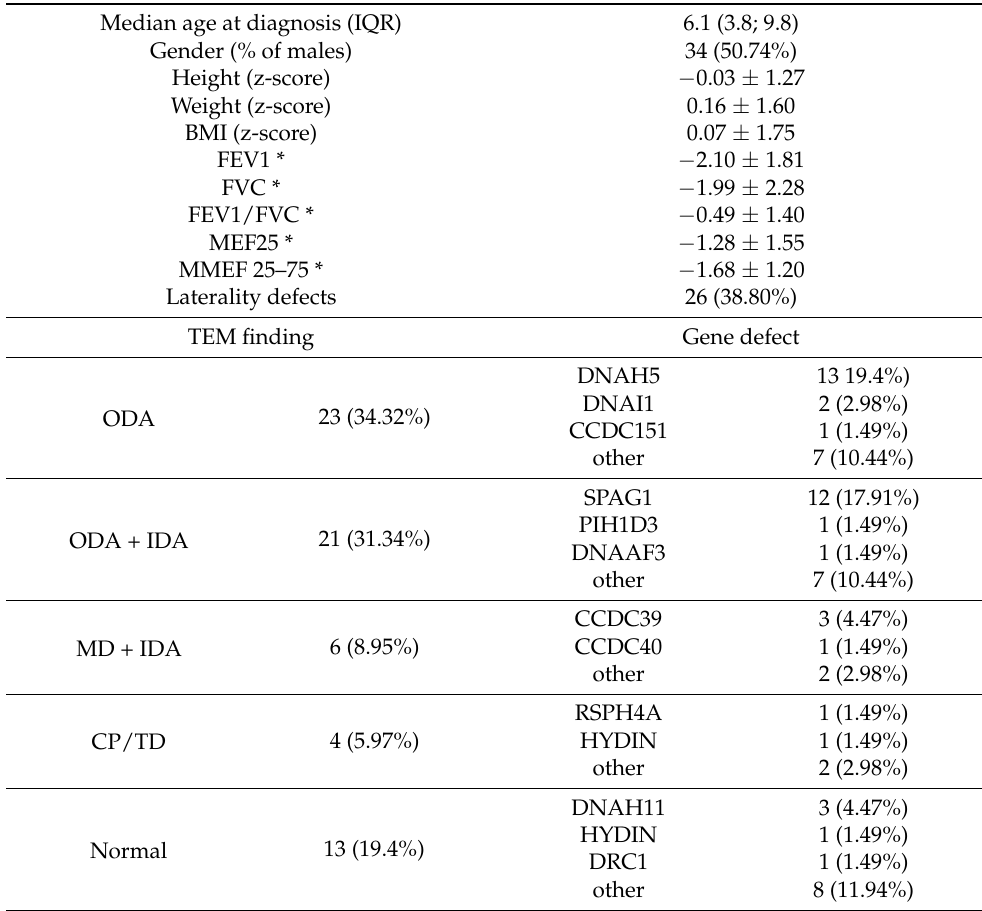
Figure 1. The age spectrum of the 1401 enrolled patients. Table 3. Characteristics of 67 PCD patients, including anthropometrics, spirometry, laterality defects, TEM, and genetic findings.